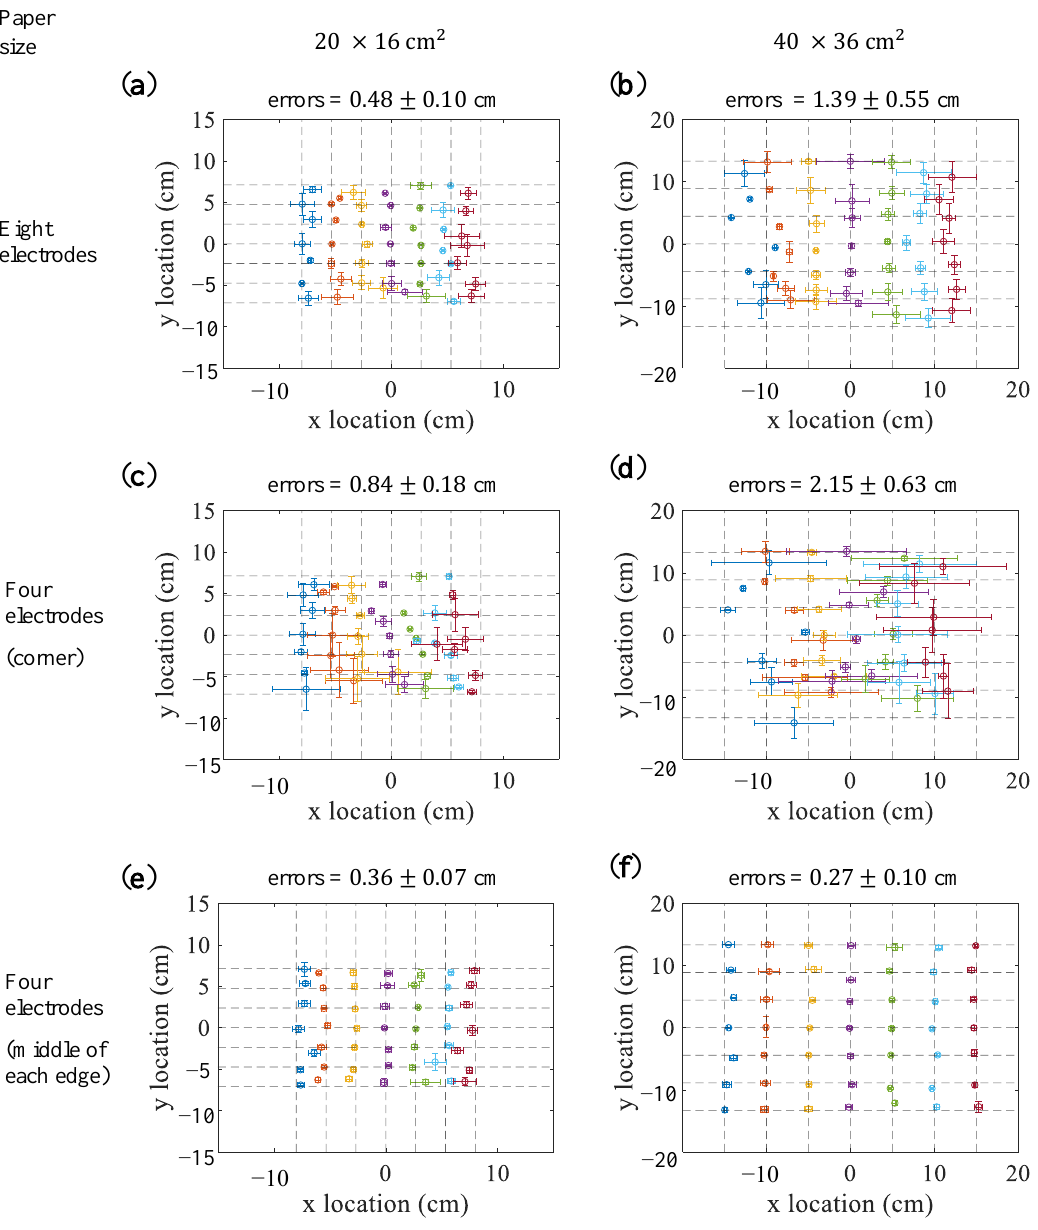
Figure 5. Results of the simple regression methods. ( a , c , e ) show the results for the 20 × 16 cm 2 paper. ( b , d , f ) show the results for the 40 × 36 cm 2 paper. ( a , b ) show the results obtained using eight electrodes. ( c , d ) shows the results obtained using four electrodes placed in the corners of the paper. ( e , f ) show the results obtained using four electrodes placed in the middle of the edges of the paper. The points denote the mean estimated locations for the intersection points, and the error bars denote the standard